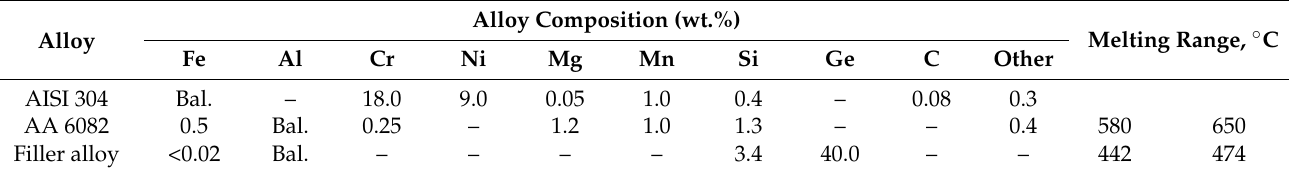
As substrate materials for determining the wettability of materials with filler alloys, sheets of aluminum alloy AA 6082 with dimensions 40 mm × 40 mm × 3 mm and stainless ‐ 79) were used. The filler alloy was applied in the form of 8 layers of foil with a thickness of 55 μ m and dimensions of 4 mm × 4 mm, stacked on top of each other and connected by contact ‐ reactive welding. connected by contact-reactive welding.